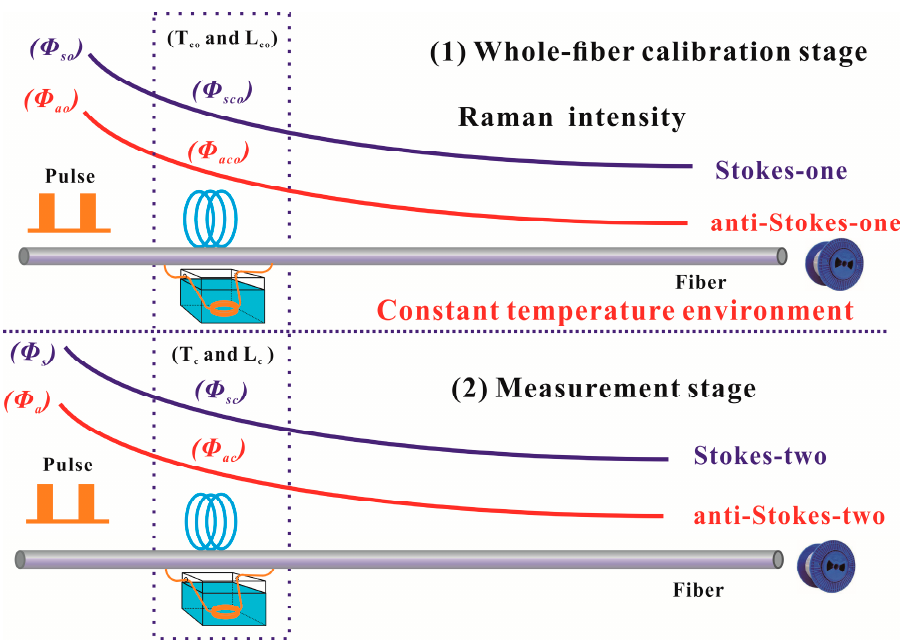
Figure 3. The traditional whole-fiber demodulation schematic diagram for DDP scheme.